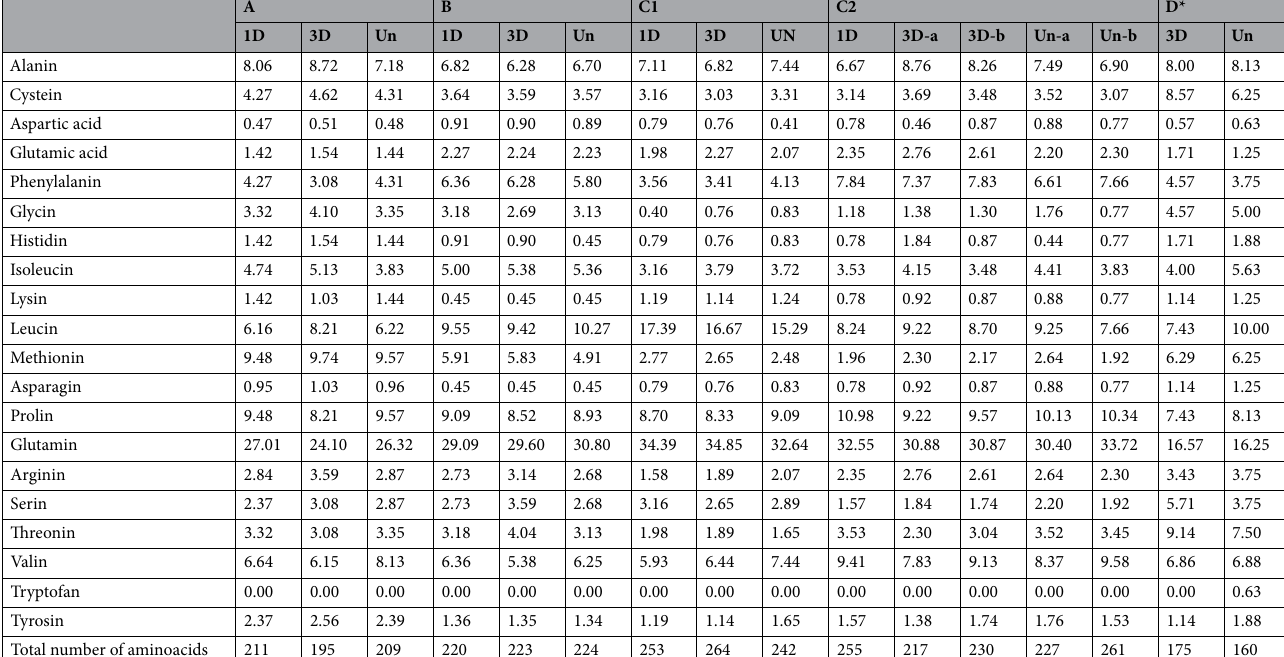
Table 2. The frequency percentage of aminoacids calculated from the detected and annotated avenin sequences. *The frequency was calculated only from those genes that do not contain excess stop codons within the